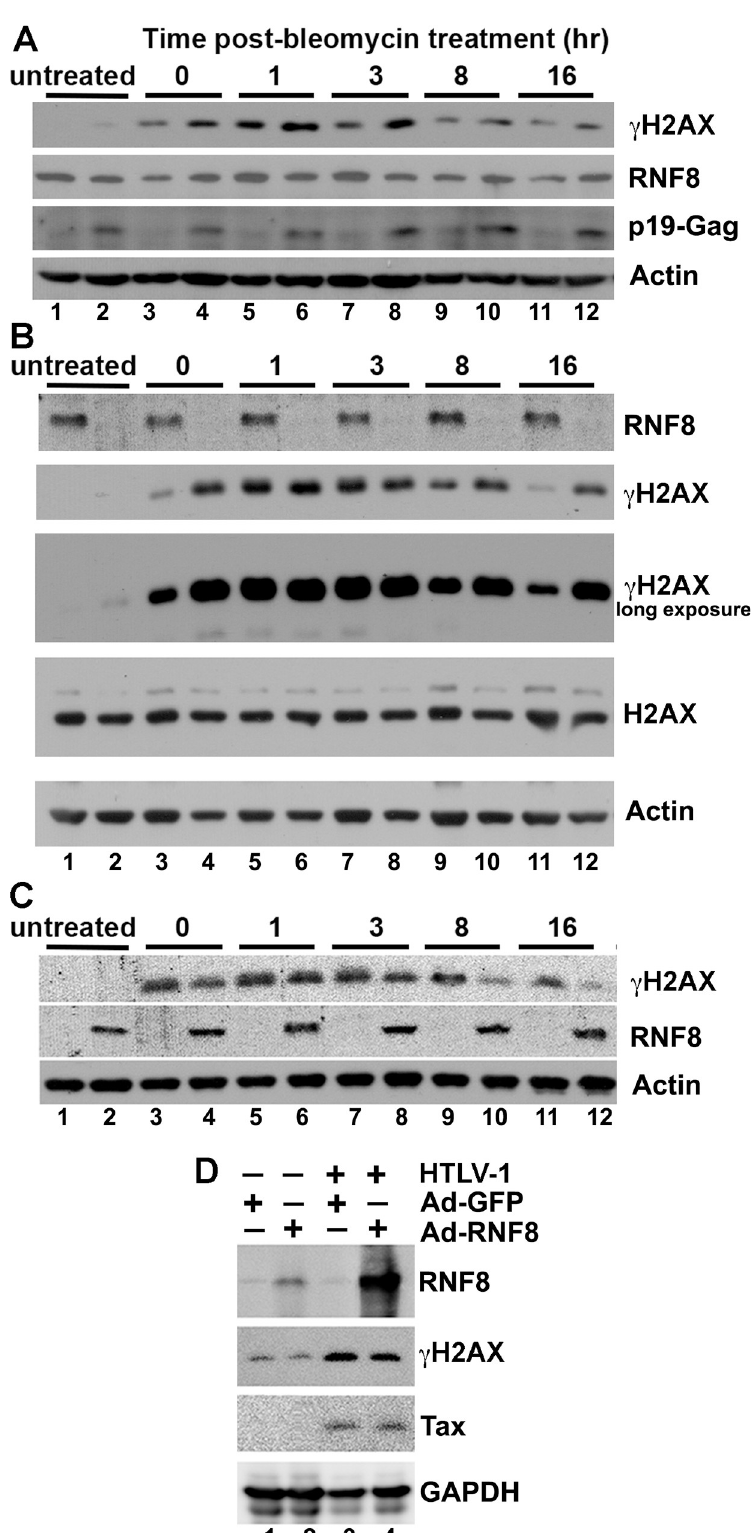
Fig 1. The DDR impairment in HTLV-1-infected HeLa cells cannot be rescued by RNF8 over-expression. (A) HTLV-1-infected HeLa cells are DDR impaired. HeLa-G: Δ N-I κ B α and its progeny, HeLa-G: Δ N-I κ B α :HTLV-1,